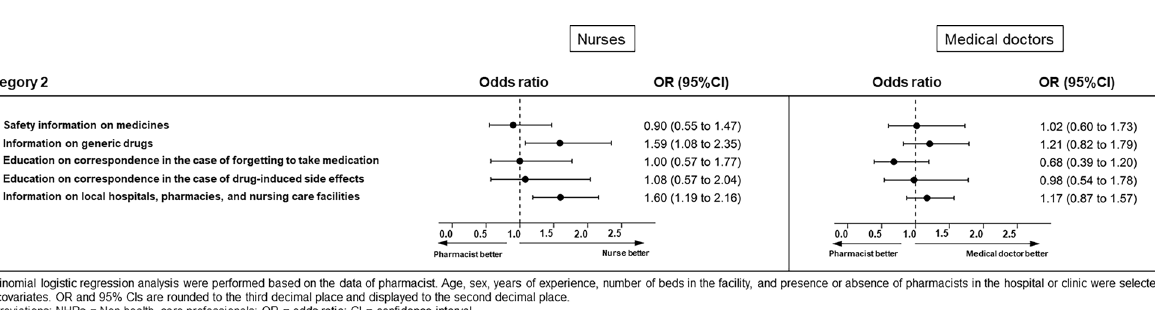
Figure 4. Results of multinomial logistic regression analysis for Category 2 for nurses or